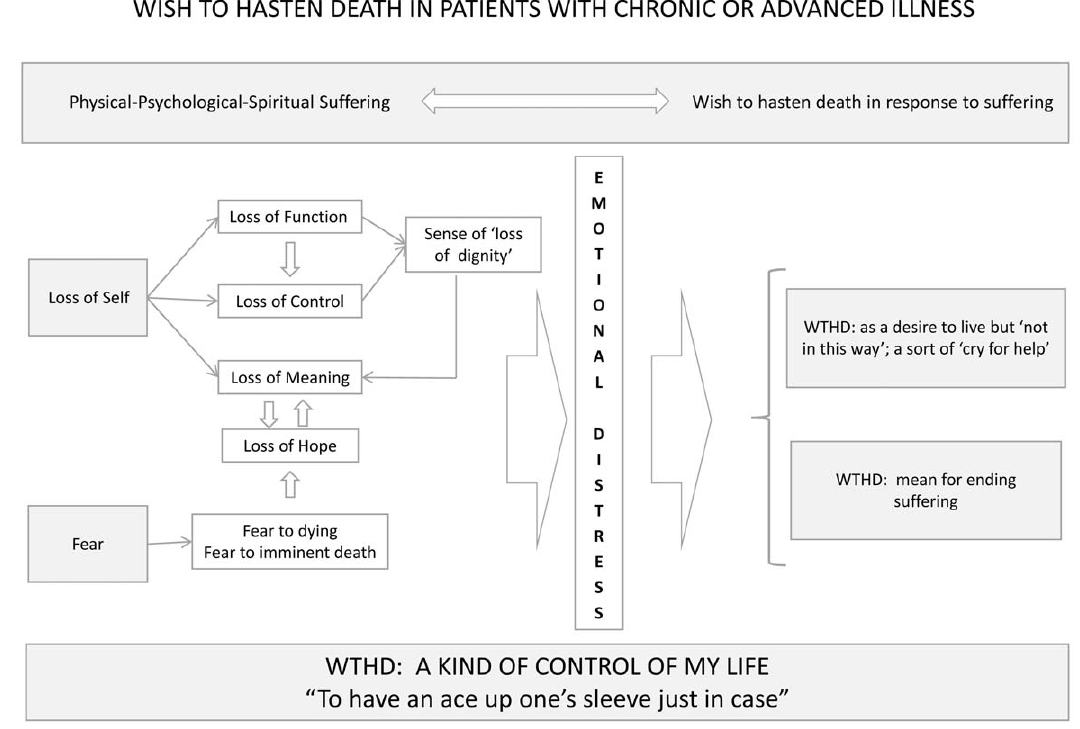
Figure 3. Line of argument: Explanatory model of WTHD.